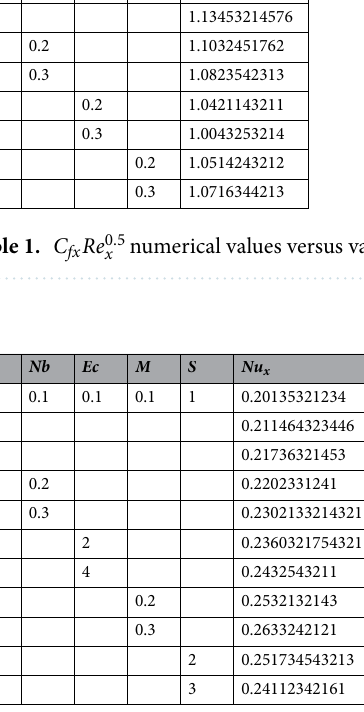
0.5 Table 2. Nu x Re − x numerical values versus various